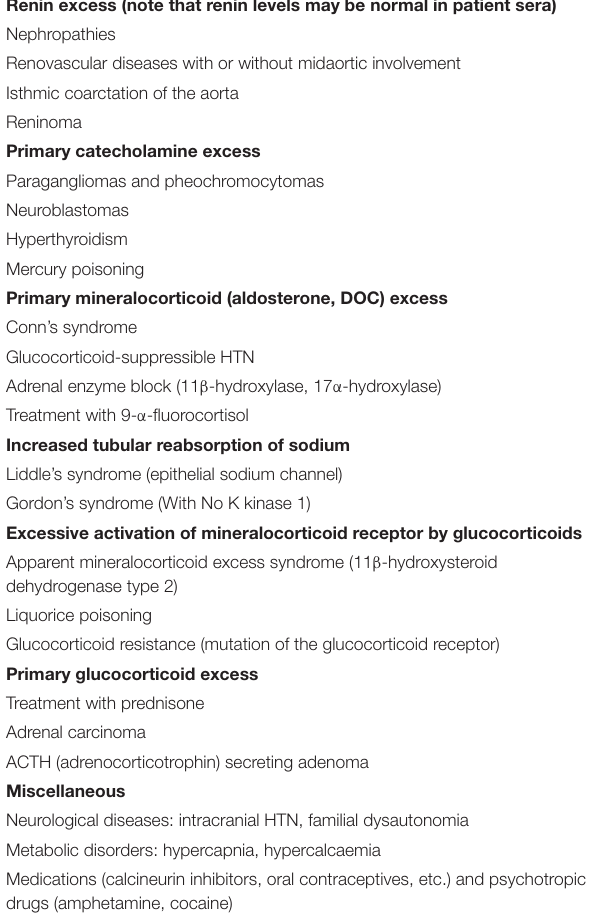
TABLE 4 | Main causes of secondary hypertension in paediatric patients. Renin excess (note that renin levels may be normal in patient sera)